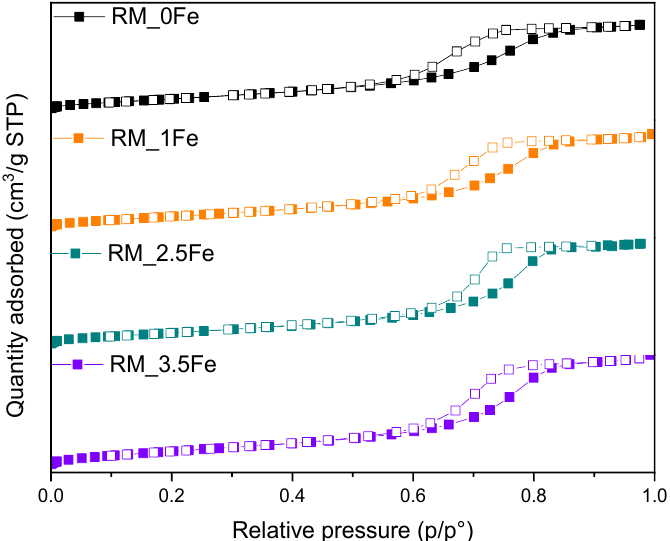
Figure 4. N 2 adsorption/desorption isotherms at − 196 °C on the studied samples: RM_0Fe (black squares), RM_1Fe (orange squares), RM_2.5Fe (green squares) and RM_3.5Fe (violet squares). Full and empty symbols refer to adsorption and desorption run, respectively. Table 2. Nominal Fe content (wt.%), nominal Fe/Ti atomic ratio and surface Fe/Ti atomic ratio (as determined by the survey XP Spectra in Figure 5); BET SSA and total pore volume, as obtained by N 2 isotherms at − 196 °C; band gap energy (Eg, eV) as obtained by linear extrapolation of the